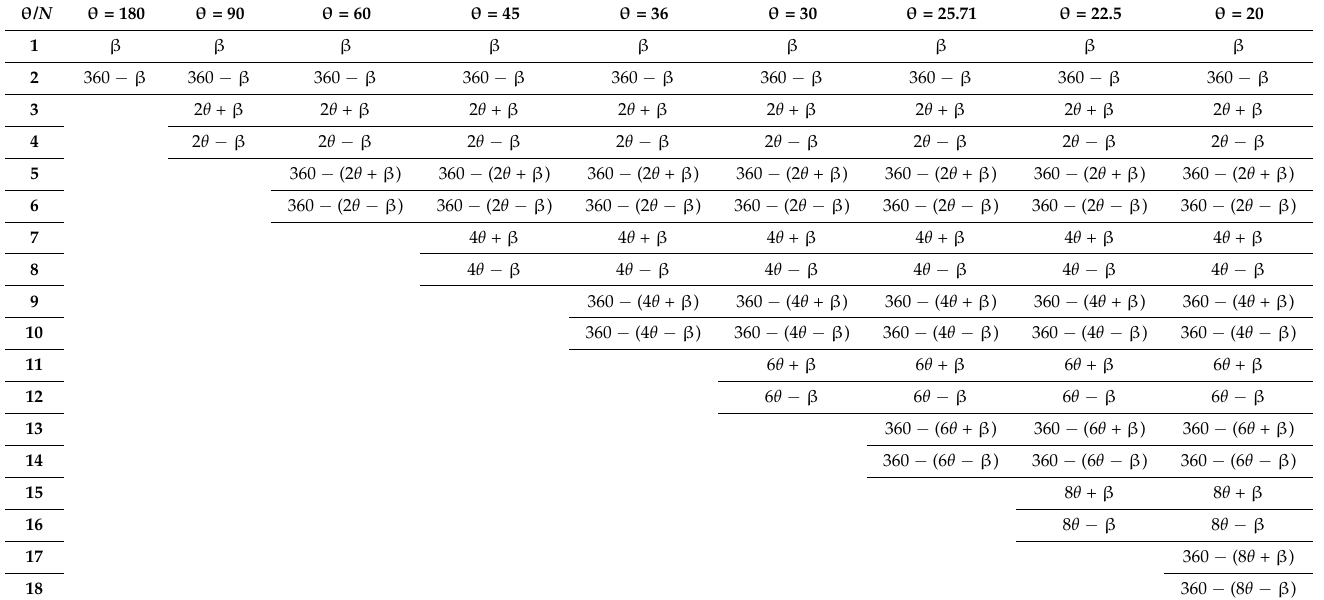
Table 1. Wave train directions, β ’, (in degrees) for N considered WECs (wave energy converter) and various breakwater angles θ (in